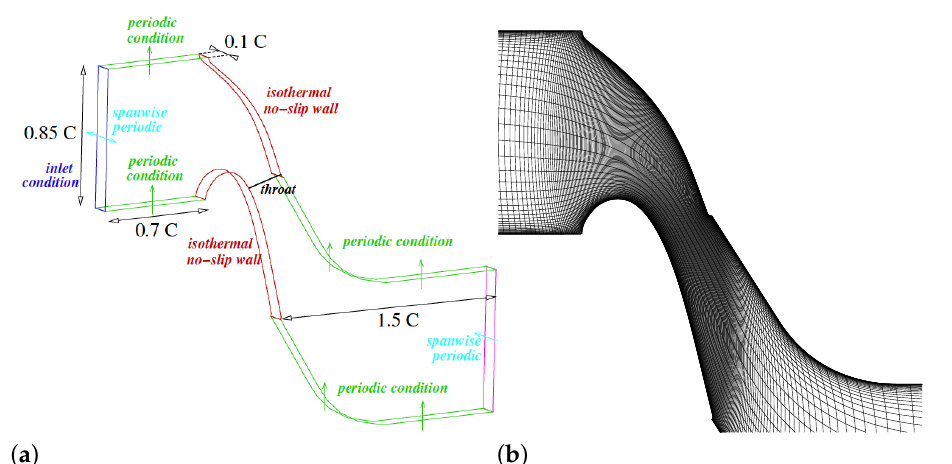
Figure 2. Computational domain with boundary conditions ( a ), and close-up view of the grid ( b ), where one point out of four is